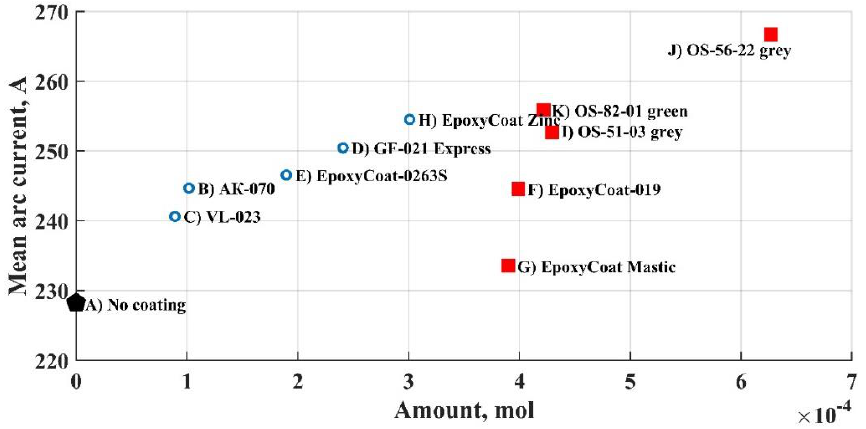
Figure 7. The mean arc current vs. oxygen amount.